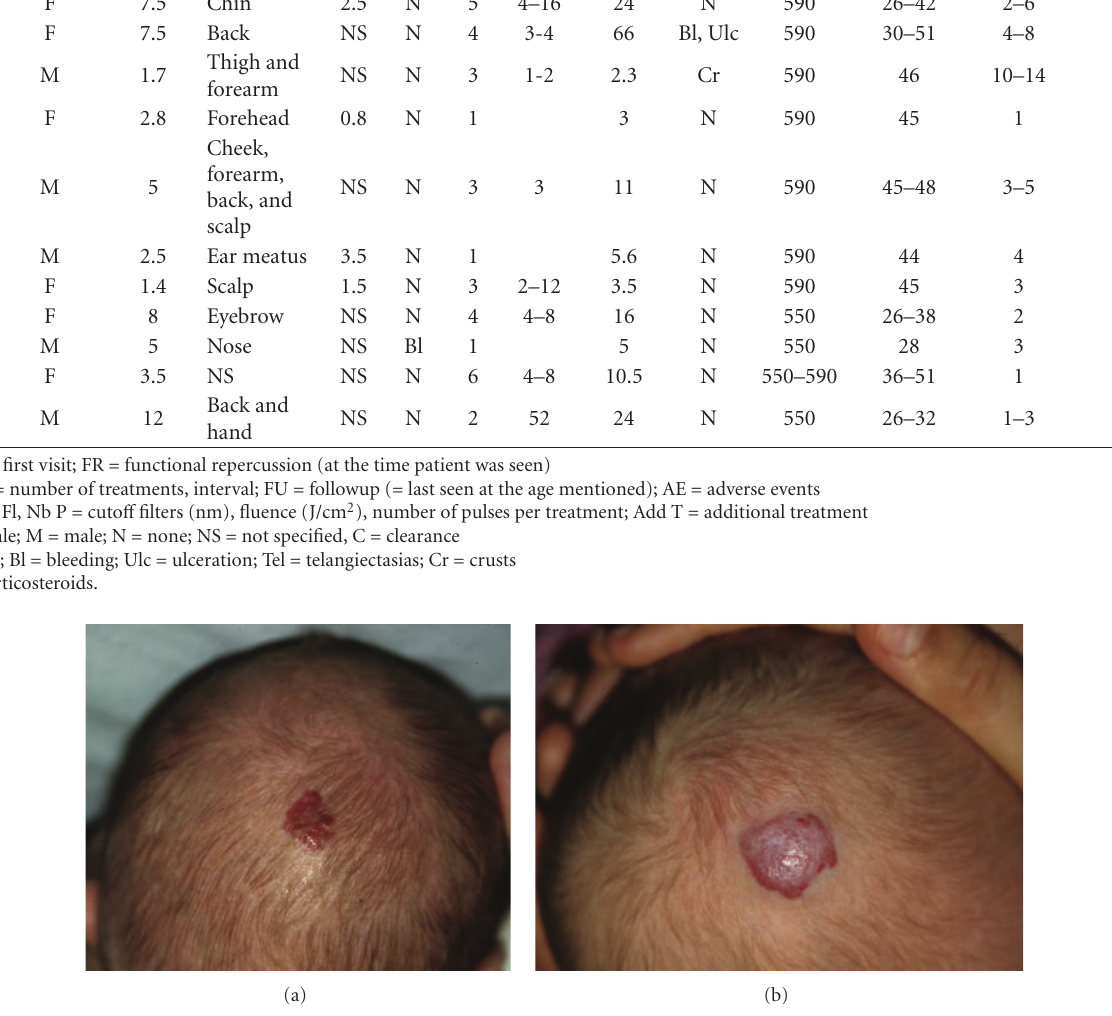
Figure 1: Infant 1 with haemangioma of the scalp, before and after 3 treatments with